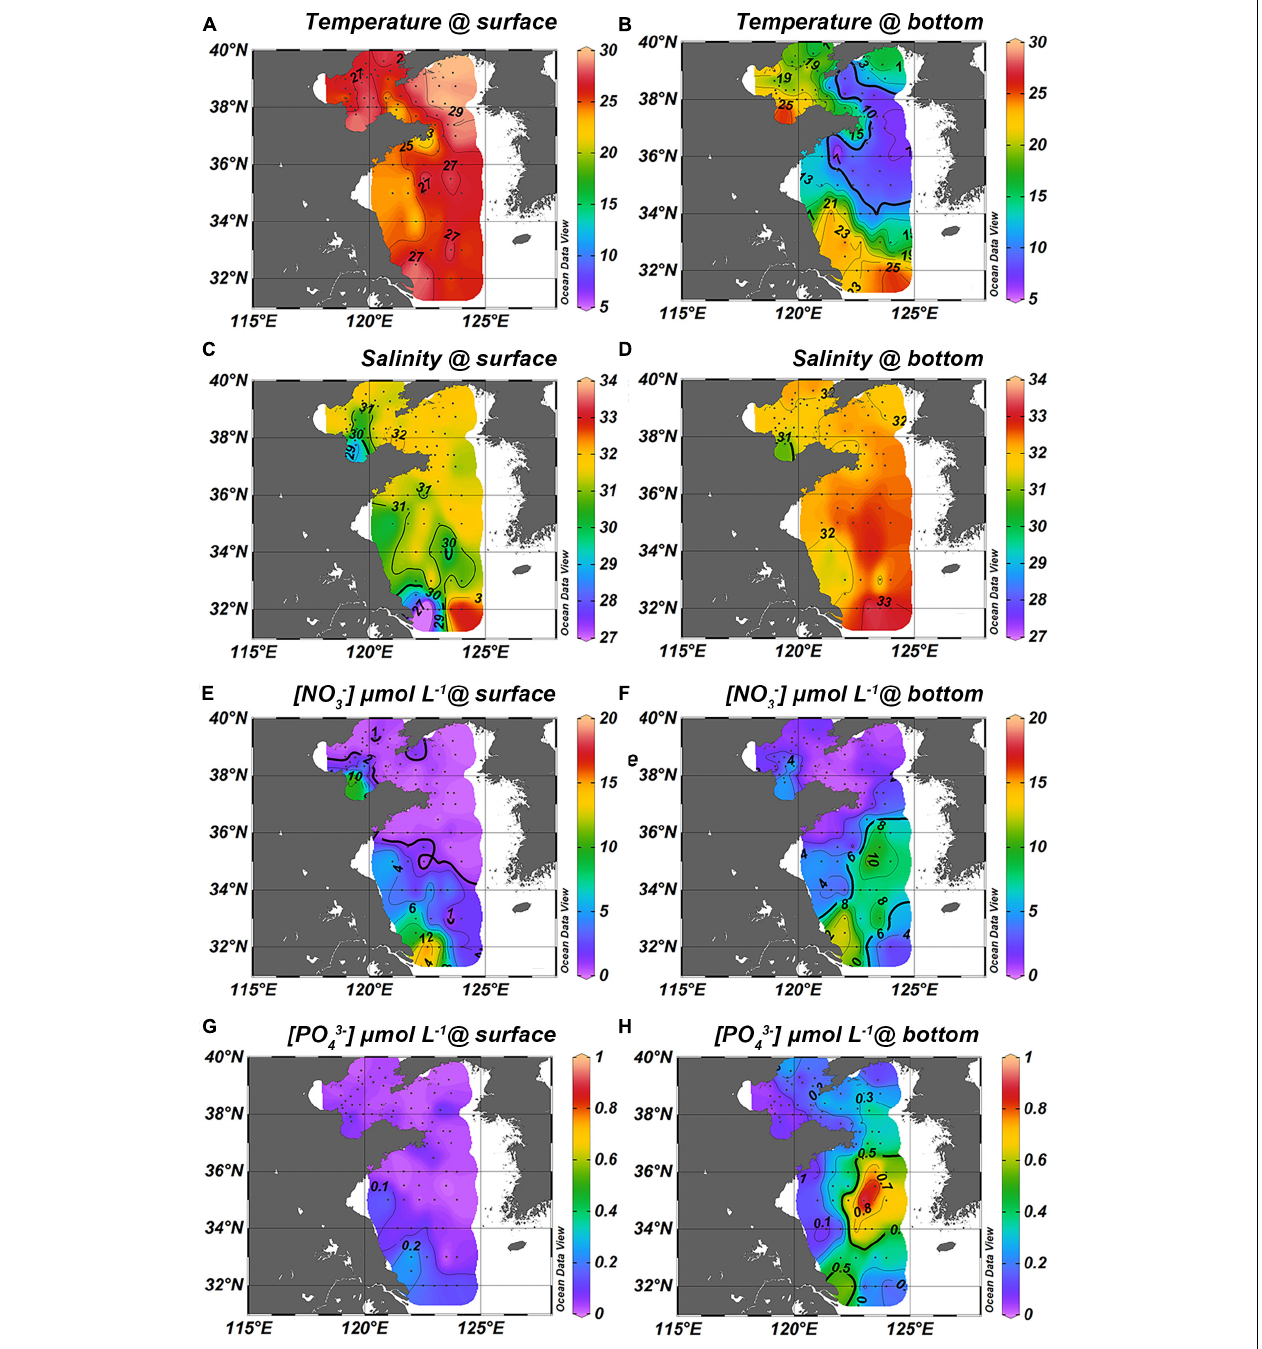
FIGURE 4 | Patterns of temperature, salinity, nitrate and phosphate in summer. The left column (A,C,E,G) are surface layers while the right column (B,D,F,H) is the bottom layers [data of the Bohai Sea shown in this figure were sampled in the same campaigns with the Yellow Sea, more details are in Tian et al. (2020),